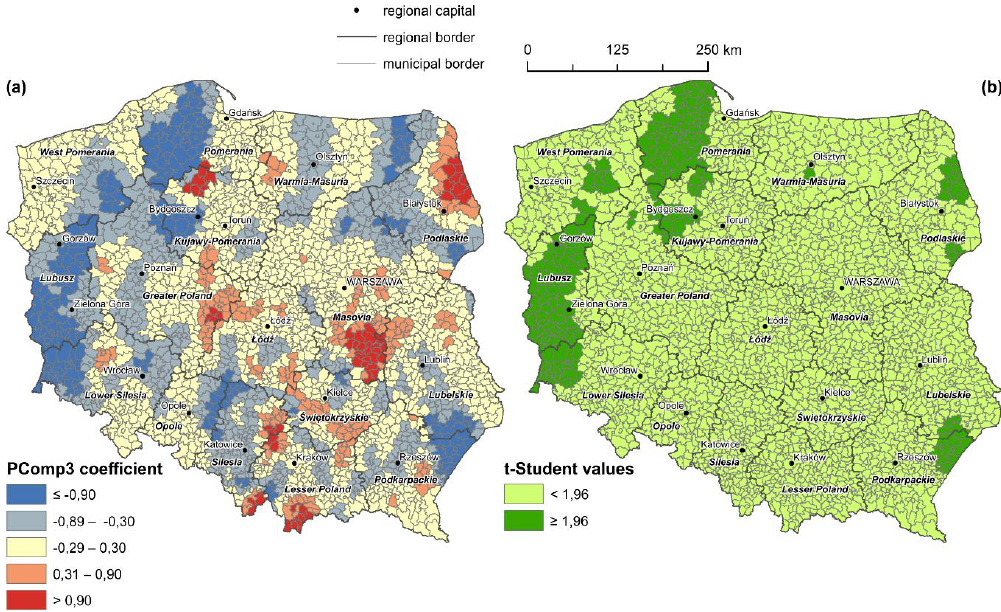
Figure 7. Value ( a ) and significance ( b ) of impact of the third component “land fragmentation” on land cover changes in Poland, in the years